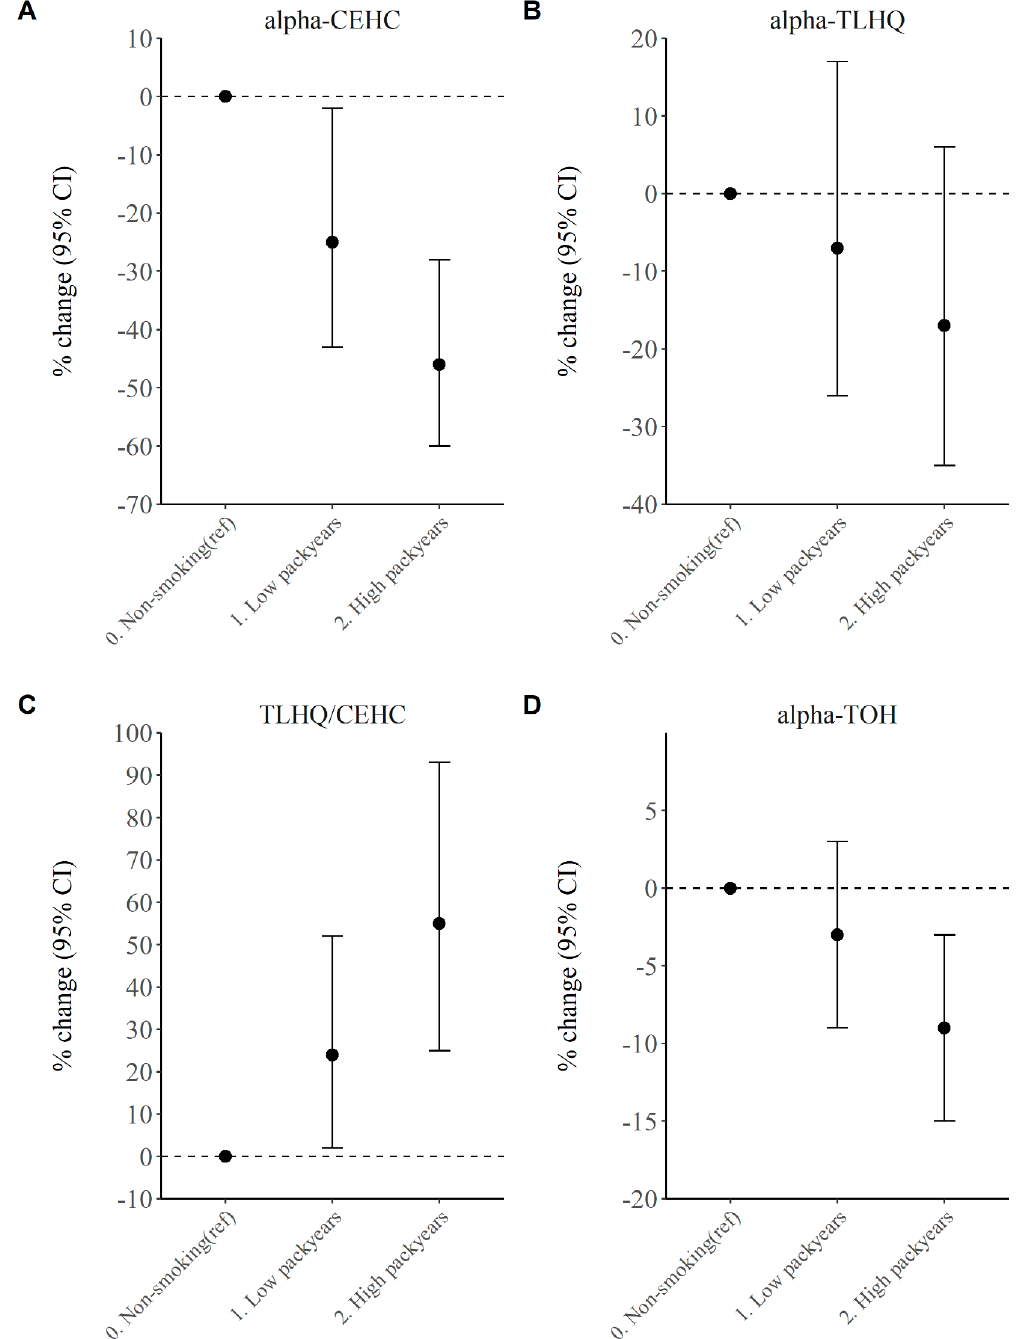
Figure 1. ( A ) Association between smoking intensity and urinary vitamin E metabolite α -CEHC in current smokers. ( B ) Association between smoking intensity and urinary vitamin E metabolite α -TLHQ in current smokers. ( C ) Association between smoking intensity and urinary vitamin E metabolite α -TLHQ relative to α -CEHC in current smokers. ( D ) Association between smoking intensity and urinary vitamin E metabolite α -TOH in current smokers. Results are derived from linear regression model adjusted for age, sex, BMI and alcohol with 95% confidence interval (CI) and presented as percentage di ff erence compared with the reference group. Of the current smokers, the 50% with the lowest pack years is considered the low pack years group, whereas the highest 50% is in the high pack years group. CEHC, carboxymethyl-hydroxychroman.